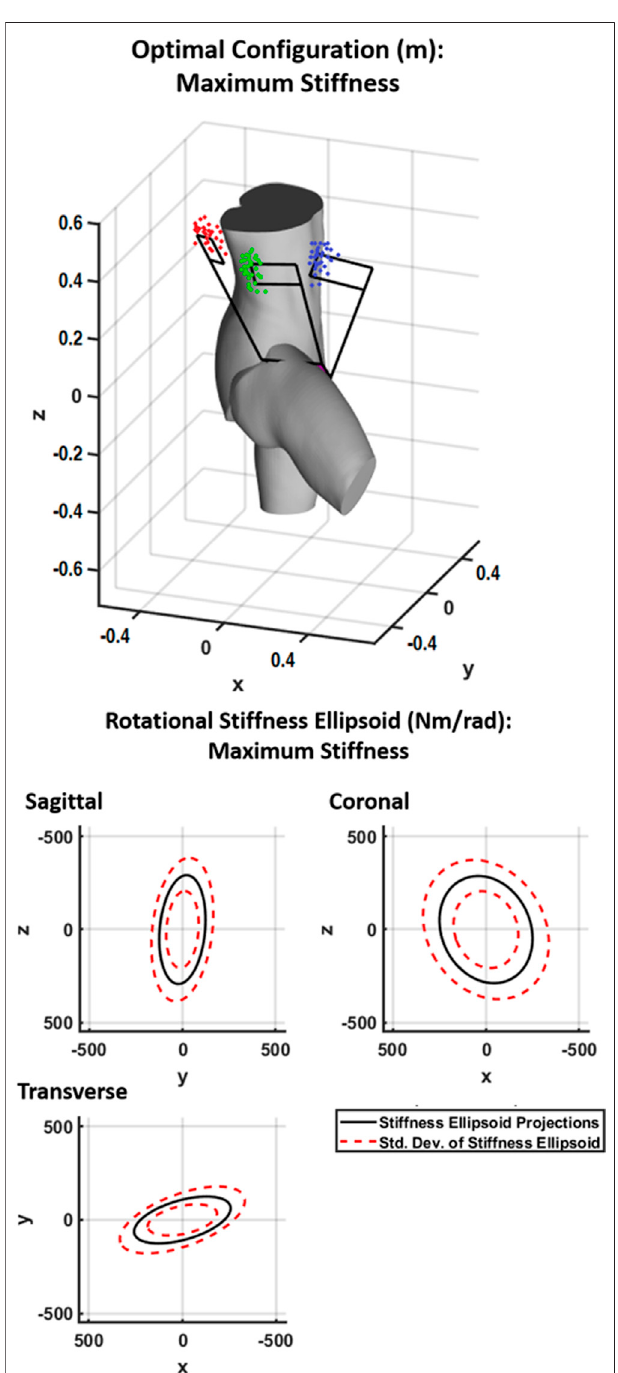
FIGURE 8 | Shown at top is the generalized maximum stiffness con fi guration for the 4B-SPM hip exoskeleton substructures along with point clouds of the best solutions found throughout the workspace. Shown at bottom are projections of the generalized maximum stiffness ellipsoid.